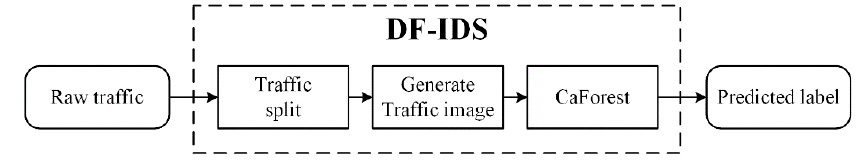
Figure 1. Flow of DF-IDS.